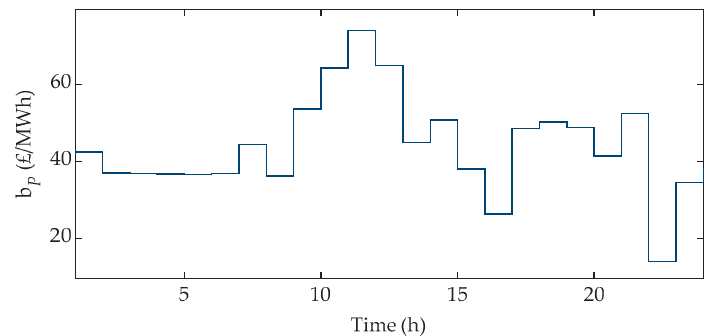
Figure 8. Active power price curve over 24 h of 19 August 2020.